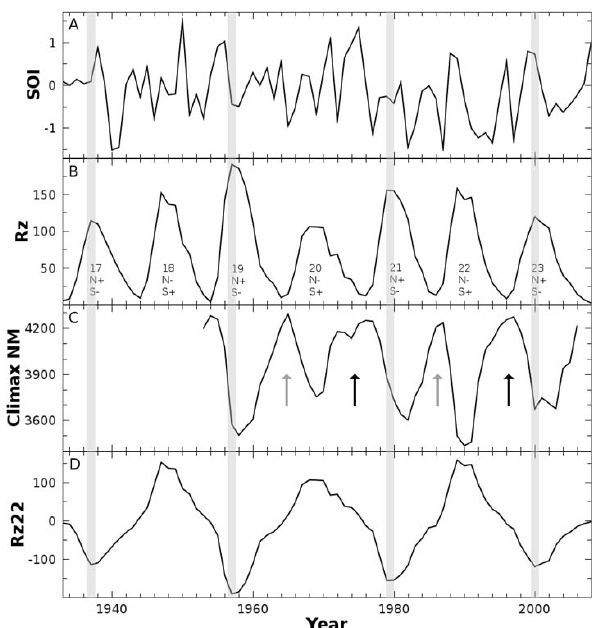
Fig. 4. Time evolution of the annual mean SOI index (A) , Rz time series (B) , neutron counts registered at the Climax Observatory (C) , and Rz22 time series (D) . The sunspot cycle number and the global solar magnetic field polarity are shown in (B) . The gray arrows (black arrows) in (C) indicate transitions from odd to even (even to odd) cycles. The shaded bands indicate the maxima of odd sunspot